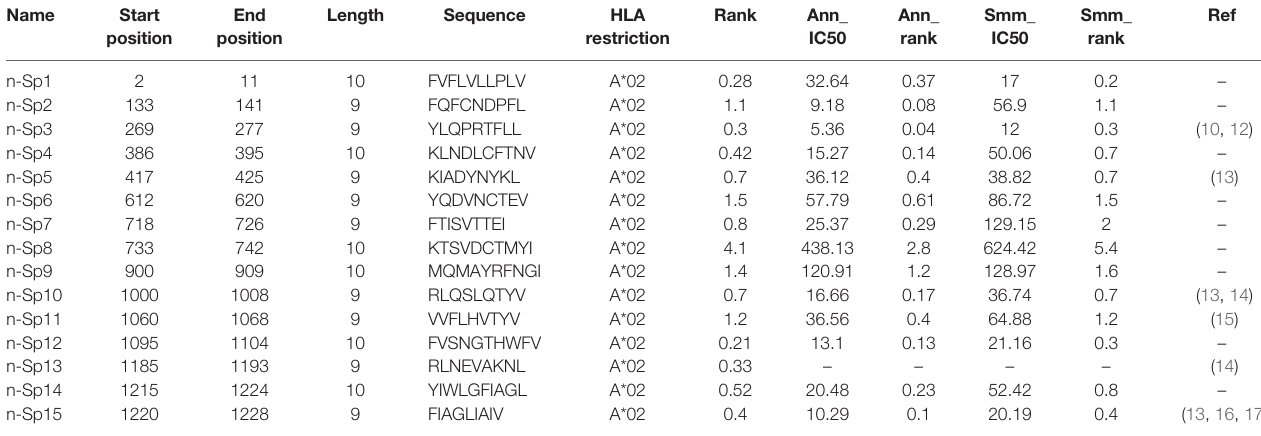
TABLE 1 | HLA-A * 02:01-restricted peptides of S protein used in this